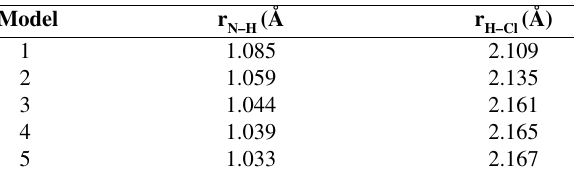
Table 8. Structural parameters for Threonine hydrochloride clu- sters optimized with M06-2X/6-31++G(d,p) method. Model